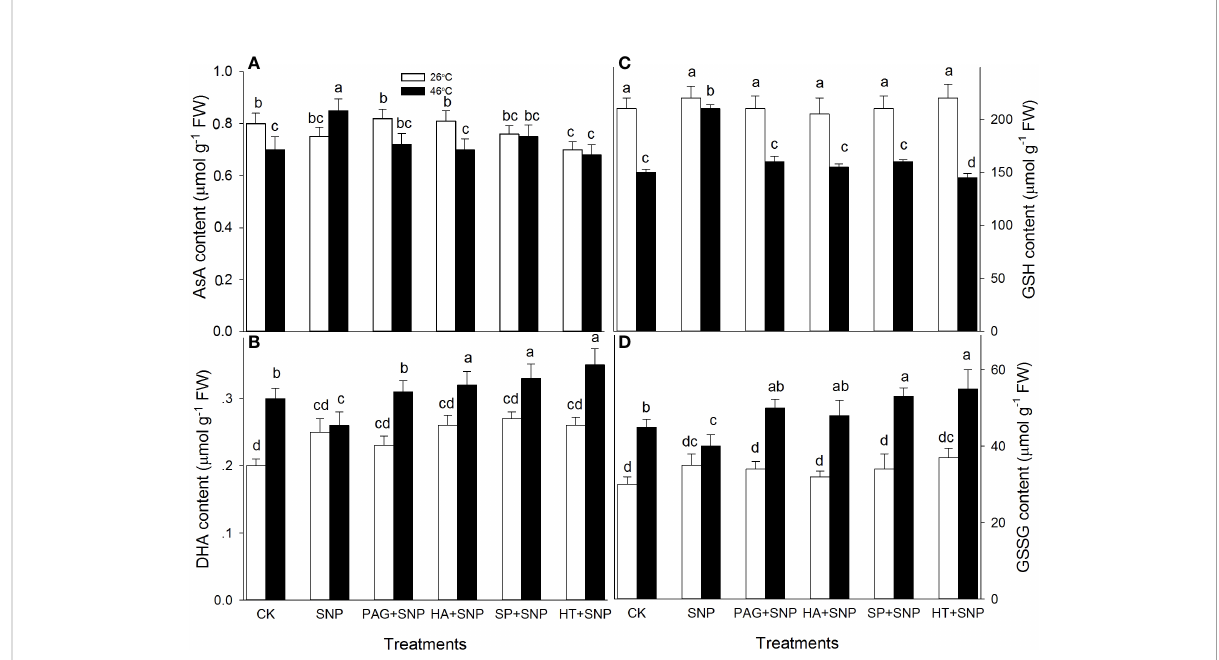
FIGURE 6 Effect of SNP alone or in combination with hydrogen sul fi de (H 2 S) inhibitors and scavengers on ascorbic acid (AsA) (A) , dehydroascorbate (DHA) (B) , reduced glutathione (GSH) (C) , and oxidized GSH (GSSH) (D) contents in maize seedlings under non-HS and HS conditions. The data had at least three biological replicates and were tested using Duncan's multiple-range test at 0.05 signi fi cant level, which denote means ± standard error (SE). The bars with the different letters represent signi fi cant differences, while the same letters represent no signi fi cant